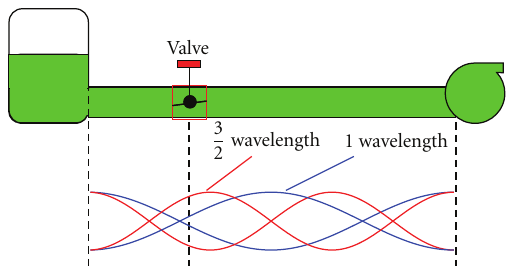
Figure 13: Geometric shape of acoustic modes in the feed line with the